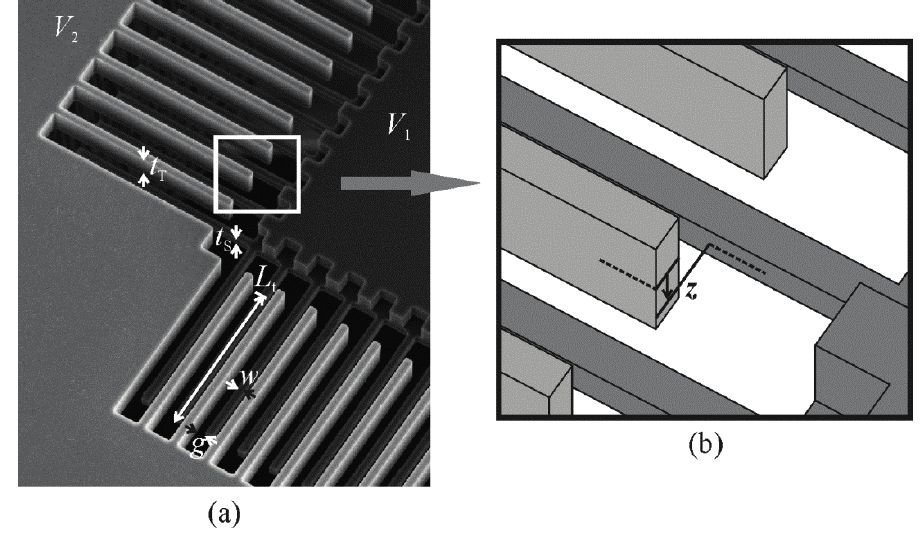
Figure 2. Some of the dimensions of the comb teeth that are expected to affect the electrostatic forces generated between them. ( b ) is an enlarged view of the area indicated in ( a ). It should be noted that “ t S ” refers to the thickness of the shorter teeth and “ t T ” to the thickness of the taller teeth, regardless of which are the fixed teeth and which are the movable